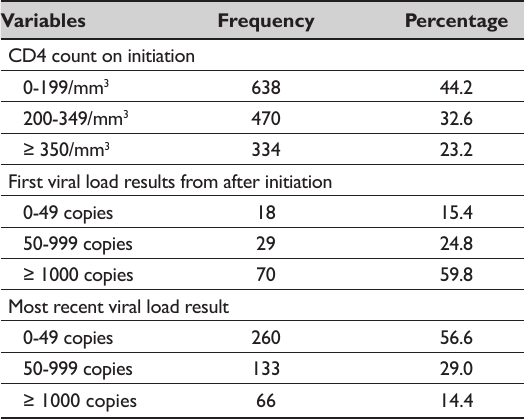
Table 4: Distribution according to CD4 count and viral load